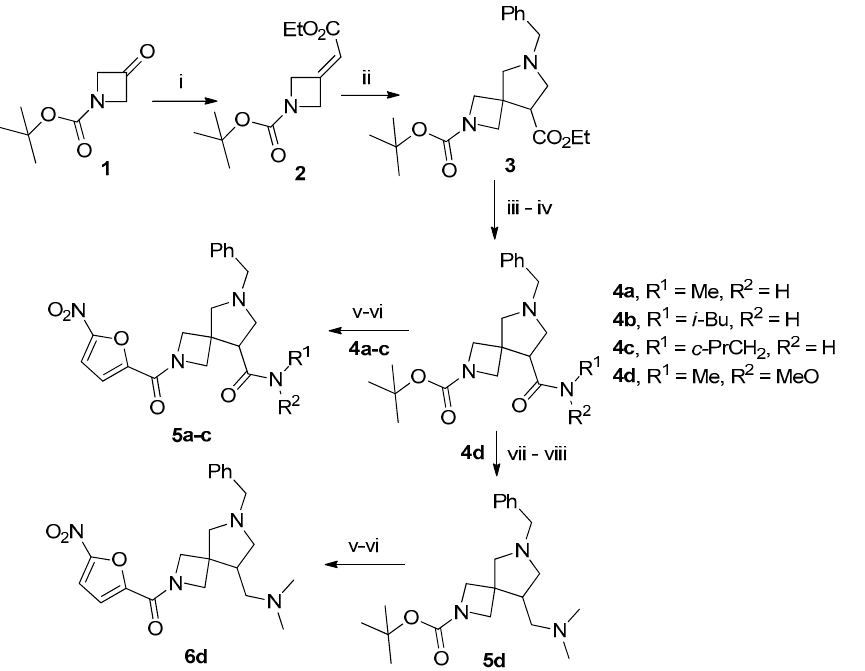
Scheme 1. Synthesis of core building block 3 and manipulation of the ester group via